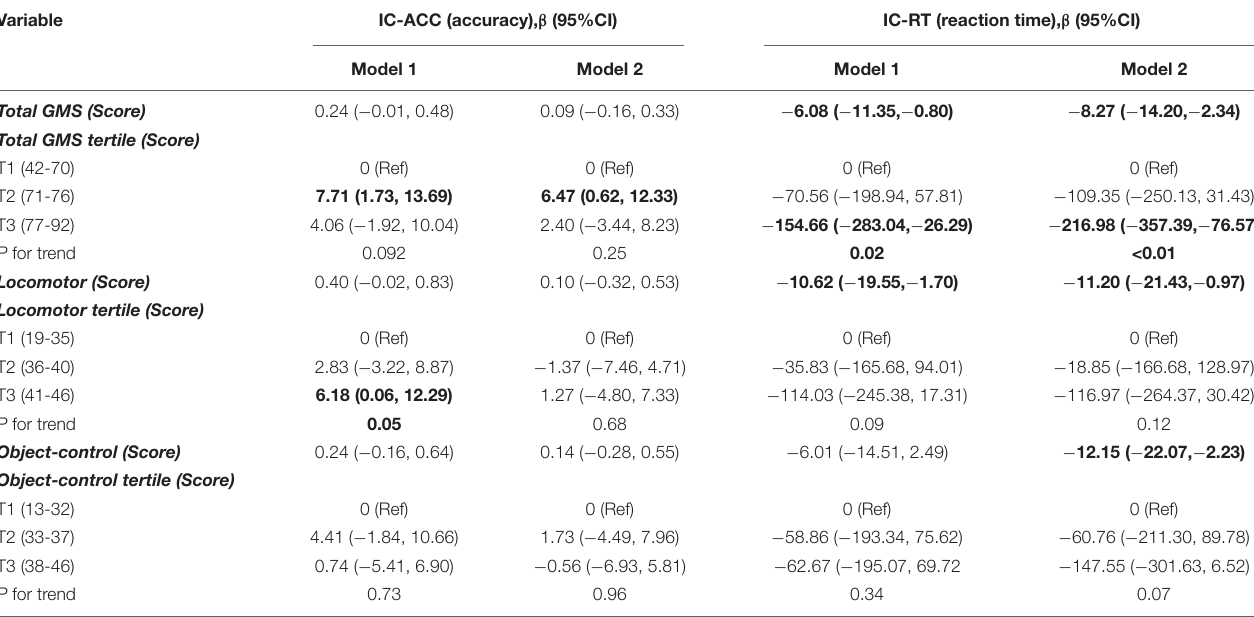
TABLE 2 | Associations between gross motor skill (Total GMS, LC, and OCS) presented as continuous scores and in Tertiles with inhibitory control scores (IC-ACC and IC-RT) on the Fish Flanker Test in preschool children ages 4-6 years ( N = 123).